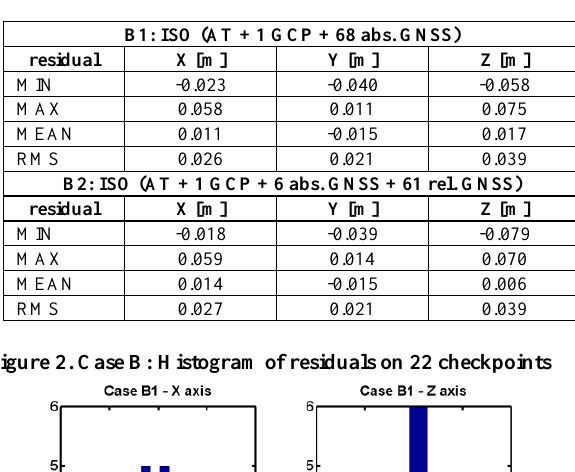
Table 4. Case B: Summary of ISO projects without bias